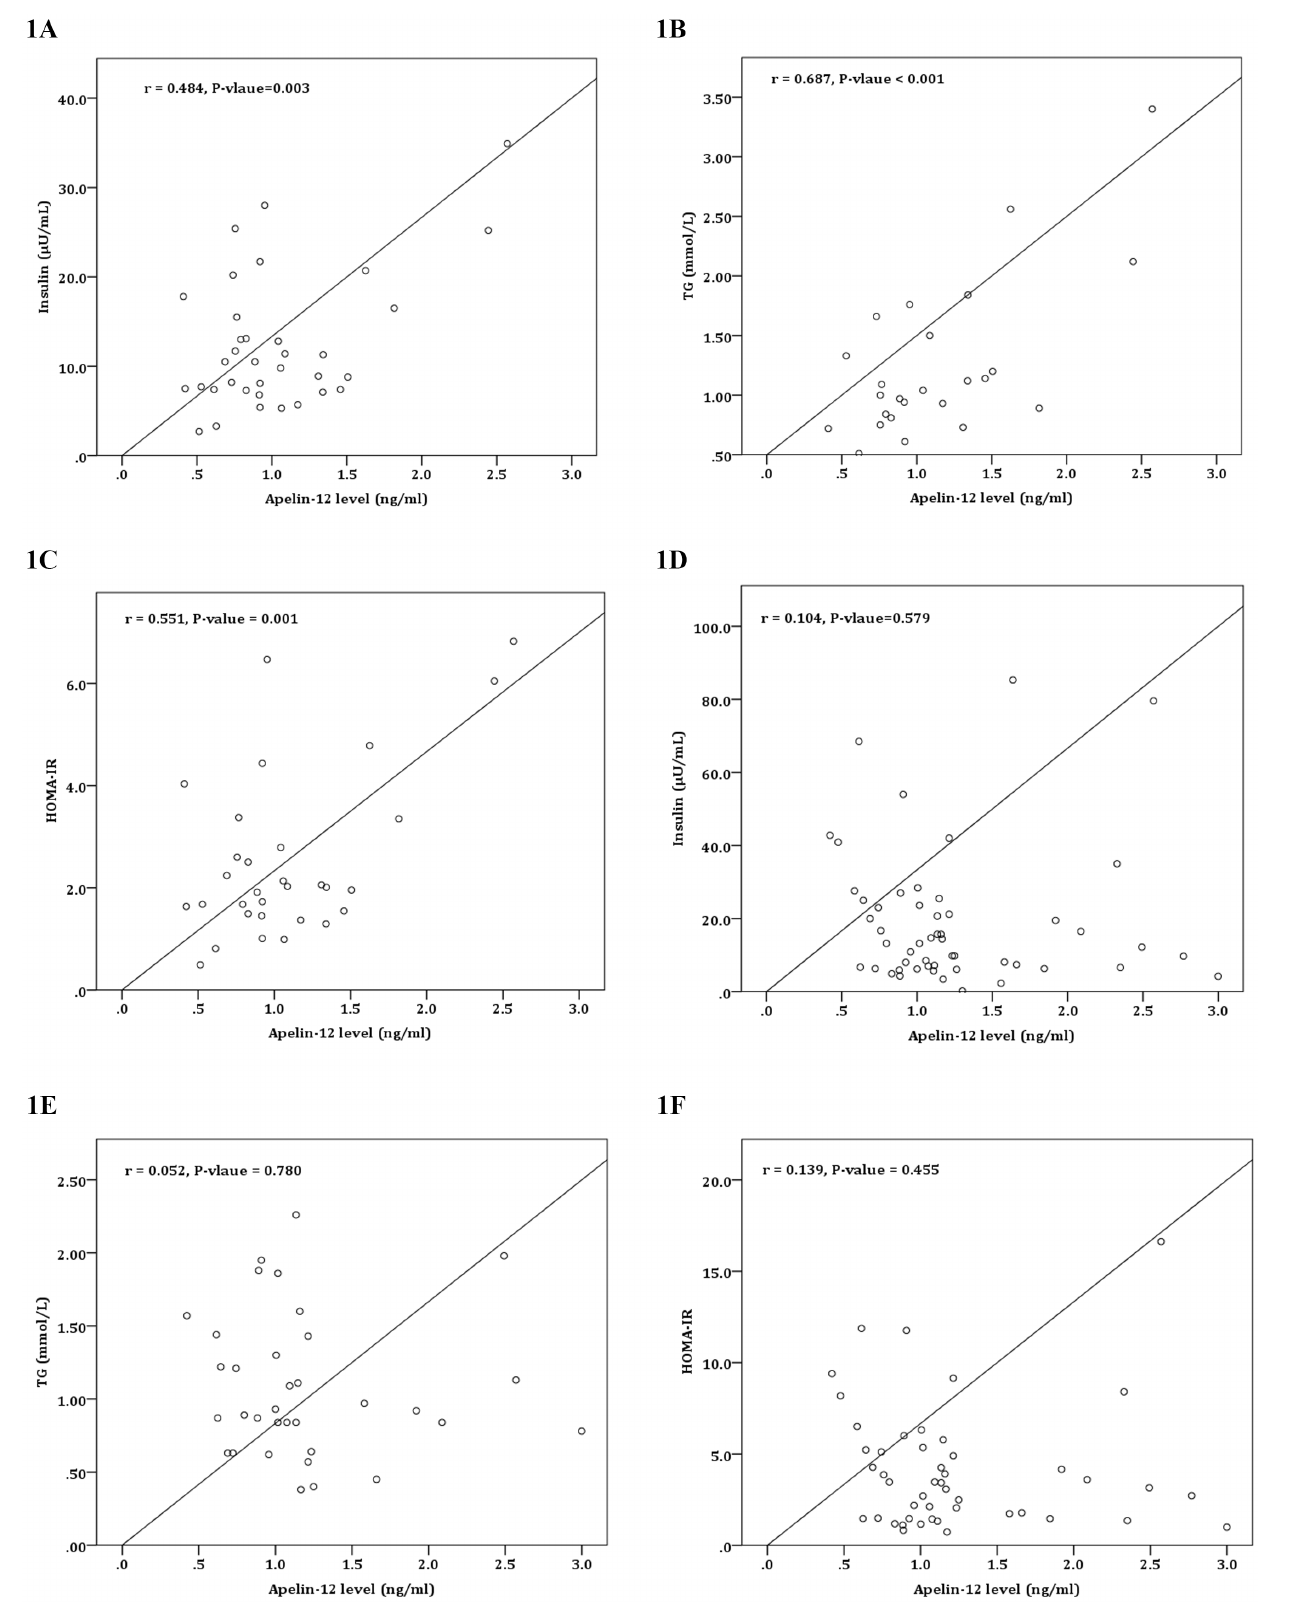
Figure 1. Associations between apelin levels, fasting insulin, triglycerides and HOMA-IR. Figure 1 depicts the association between apelin levels and (A) fasting insulin, (B) TG, and (C) HOMA-IR in female subjects and the association between apelin levels and (D) fasting insulin, (E) TG, and